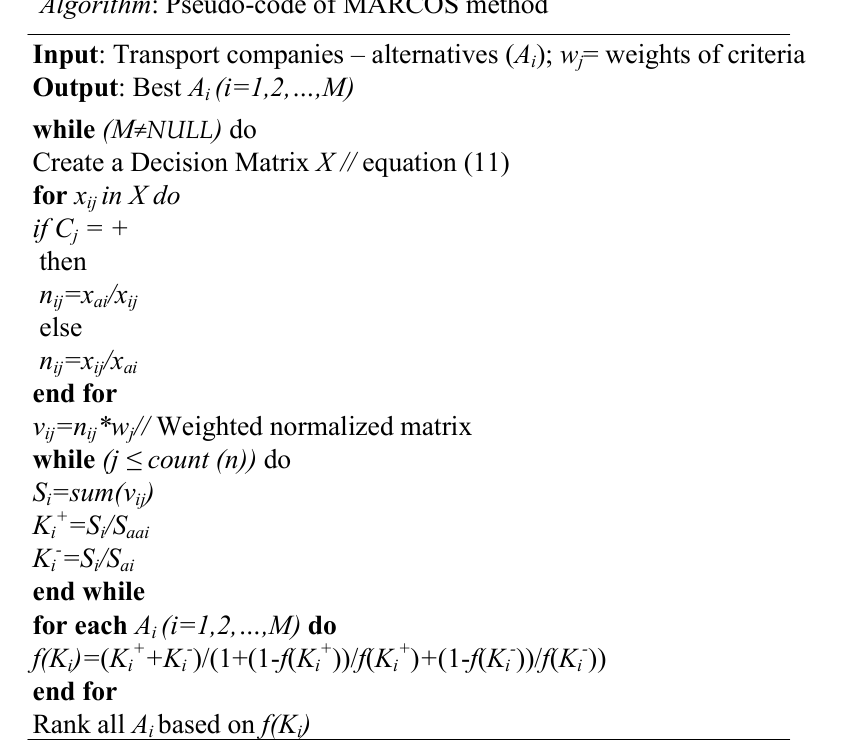
Figure 4. Pseudo-code for MARCOS method.